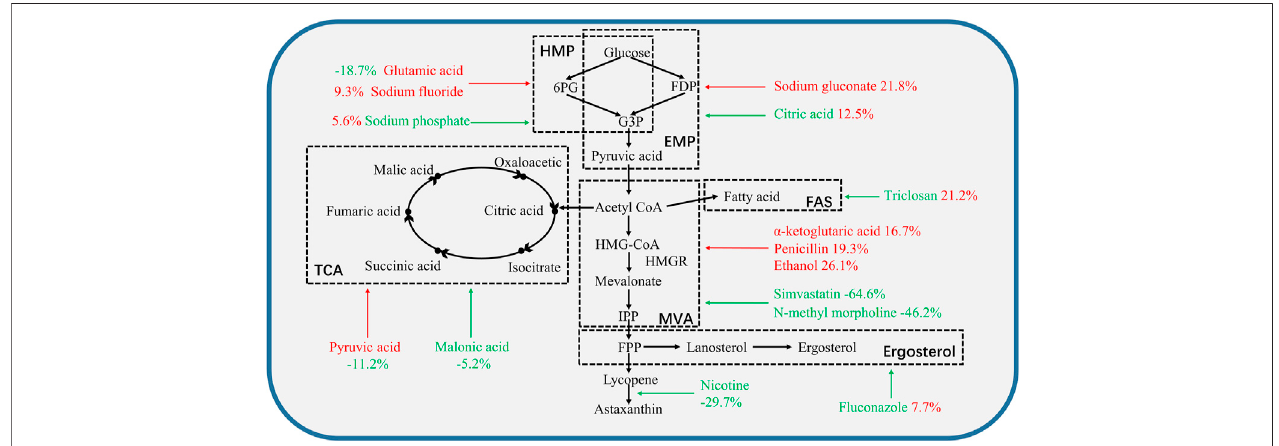
FIGURE2| Theeffect ofsingle regulator onthe metabolic pathway in P. rhodozyma MVP14. Theblack dashed lines frame thecorresponding metabolic pathways described in black bold text. The red additives represent the promoters of this pathway or enzyme. Green additives represent inhibitors of this pathway or enzyme. Red numbers mean an increase in astaxanthin cell yield. Green numbers mean reduction of astaxanthin content. The arrow points to the pathway or site affected by the corresponding additive. HMP: hexose monophosphate pathway, EMP: Embden-Meyerhof-Parnas pathway, TCA: tricarboxylic acid cycle, MVA: mevalonate pathway, FAS: fatty acids pathway, 6PG: 6-phosphogluconate, FDP: fructose-1, 6-diphosphate, G3P: glucose-3-phosphate, IPP: isopentenyl pyrophosphate, FPP: farnesyl